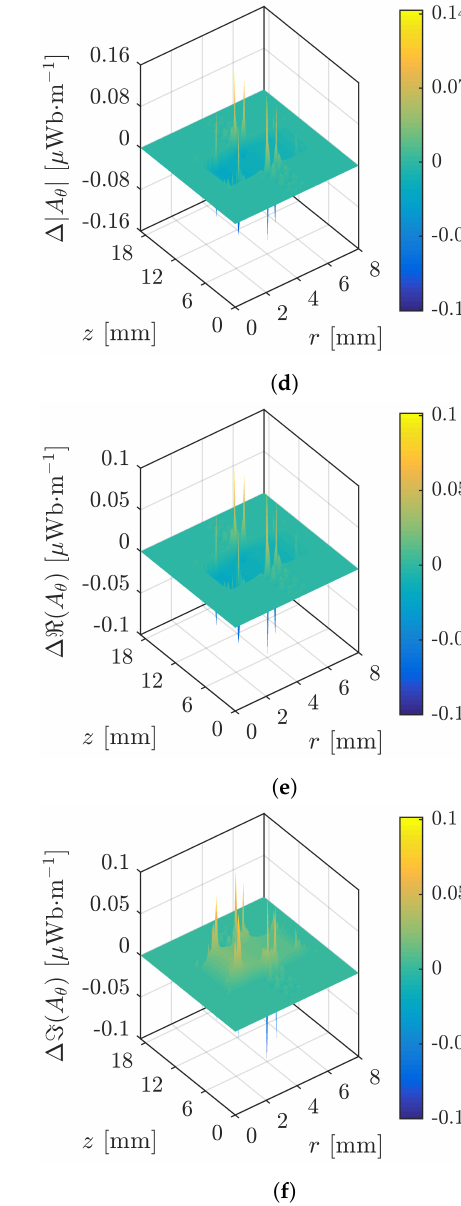
Figure 5. Magnetic vector potential in the investigated domain obtained with the SEM: ( a ) mod- ulus, ( b ) real, and ( c ) imaginary part. The difference with respect to the FEM solution is shown in ( d – f ),